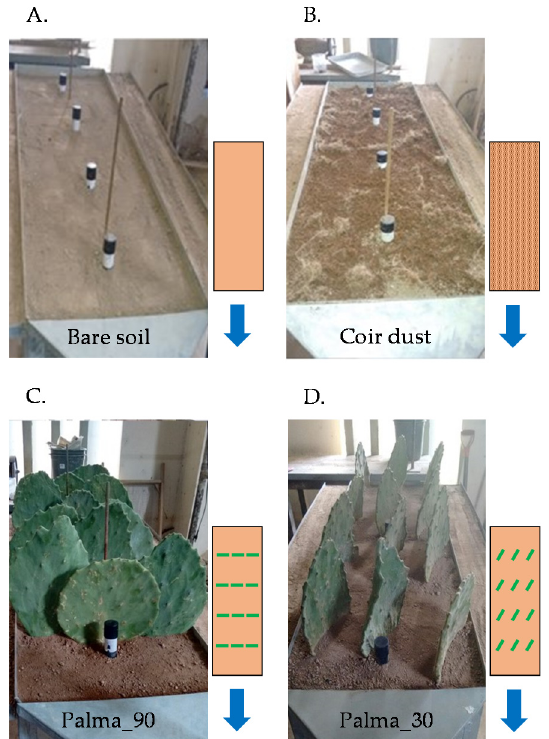
Figure 2. Photographs and schematic representations of the four soil cover conditions considered in this study: ( A ) Bare soil, ( B ) mulch cover with coir dust, ( C ) cover crop with Palma cactus plants oriented at a 90 ◦ angle with the slope direction (Palma_90) and ( D ) cover crop with Palma cactus plants oriented at a 30 ◦ angle with the slope direction (Palma_30). Light brown rectangles represent the soil flume filled with soil. Dark brown dots represent the mulch cover. Green rectangles represent the Palma cactus plants. Blue arrows represent slope direction. Photographs also show the four soil moisture sensors positioned along the flume for each treatment.